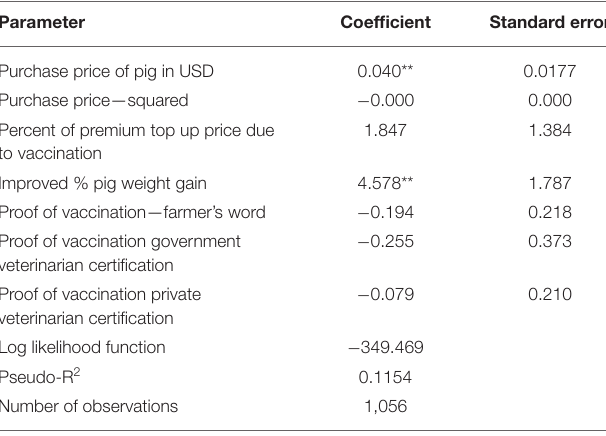
TABLE 9 | Conditional logit estimates for T. solium cysticercosis vaccinated